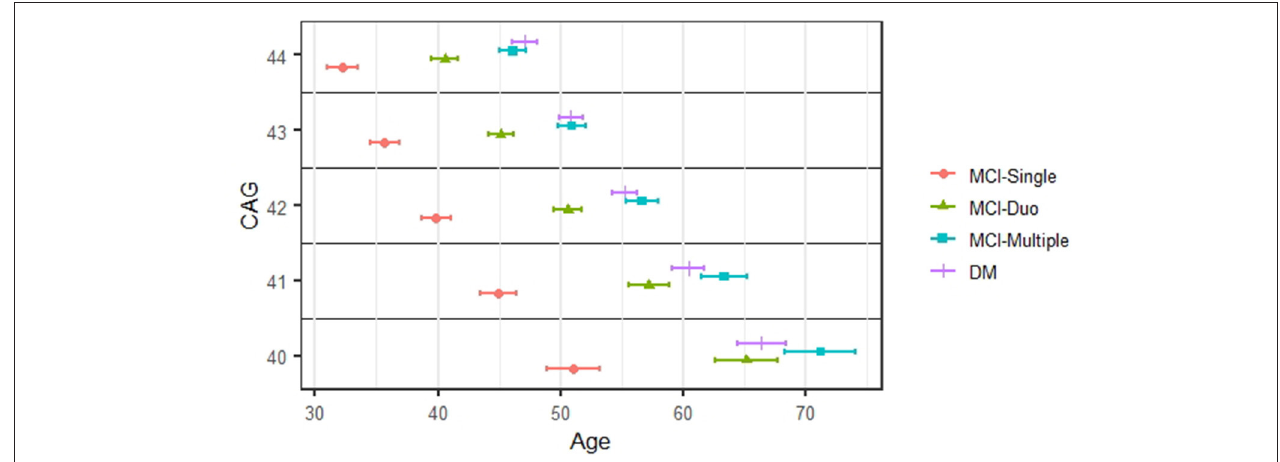
FIGURE 2 | Staging of cognitive impairment. The estimated median onset age and its 95% confidence interval for each stage of cognitive impairments.